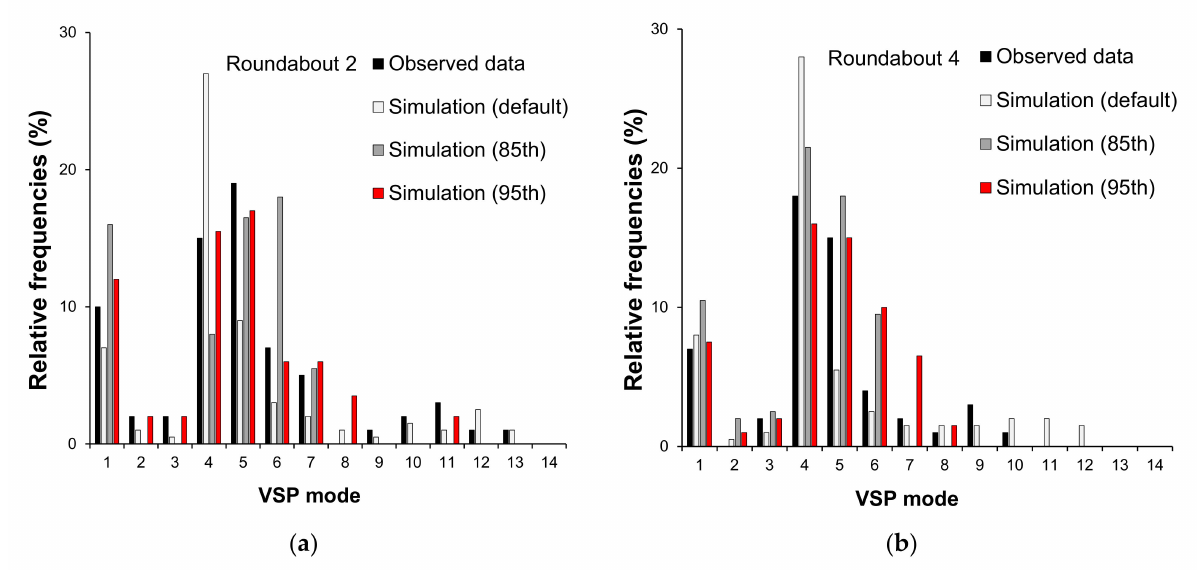
Figure 8. The relative frequencies of time spent in VSP modes under simulation with the default parameters and calibration with 85th or 95th percentile values of the selected vehicle attributes